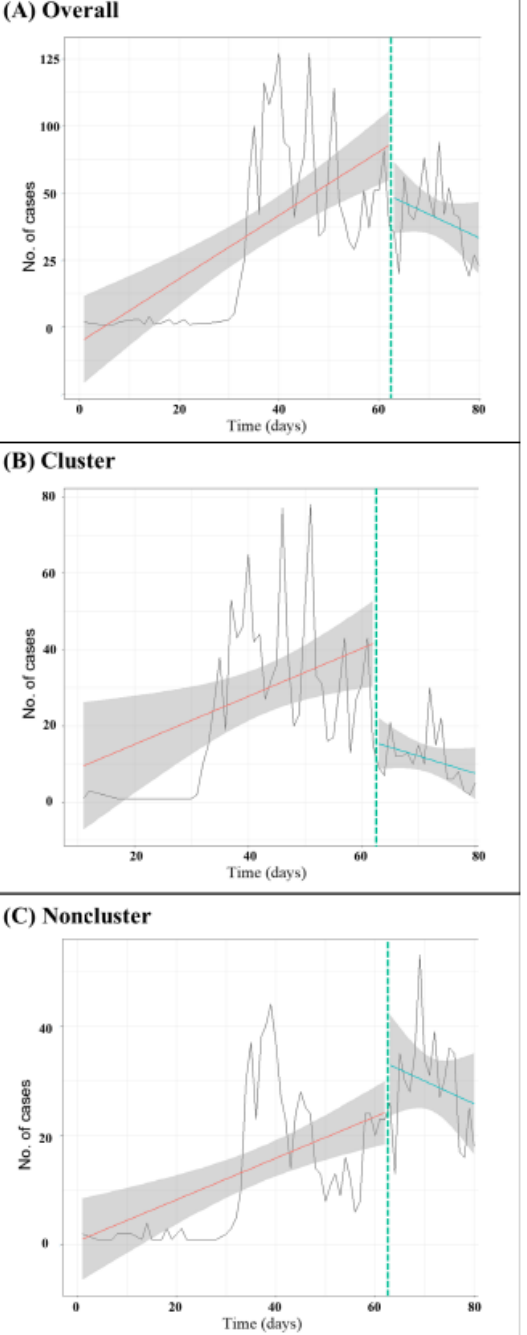
Figure 4. Number of new confirmed COVID-19 cases over the study period. The dashed vertical line at March 22, 2020, indicates the launch of the social distancing campaign. The solid red (before the social distancing campaign) and blue (after the social distancing campaign) lines represent the linear trends of new confirmed COVID-19 cases. Shaded areas represent 95% CIs for the linear